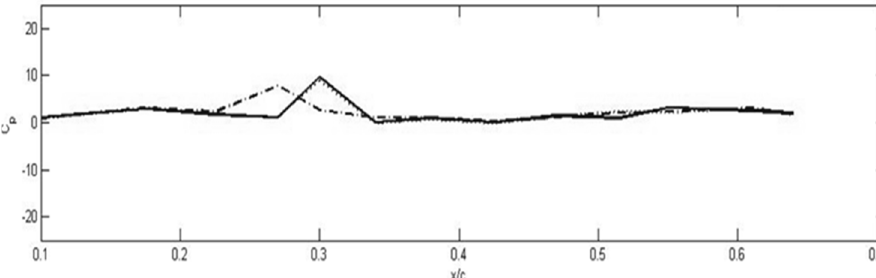
Figure 13. First derivative of the pressure distribution (Cp) of the original (not-optimized) airfoil (short dash line) and the optimized PSO airfoil (solid line).